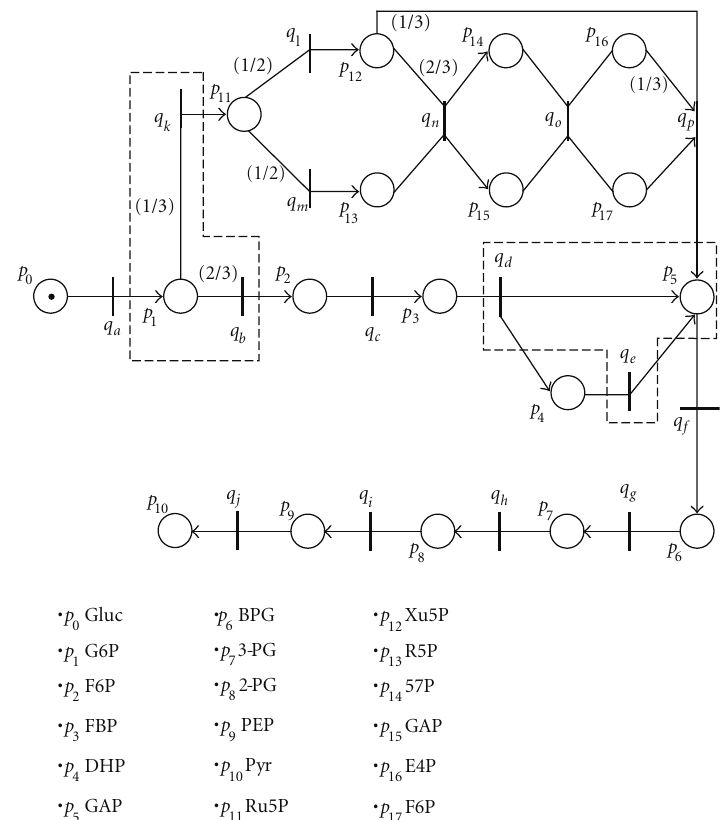
Figure 2: Glycolysis and pentose-phosphate pathways